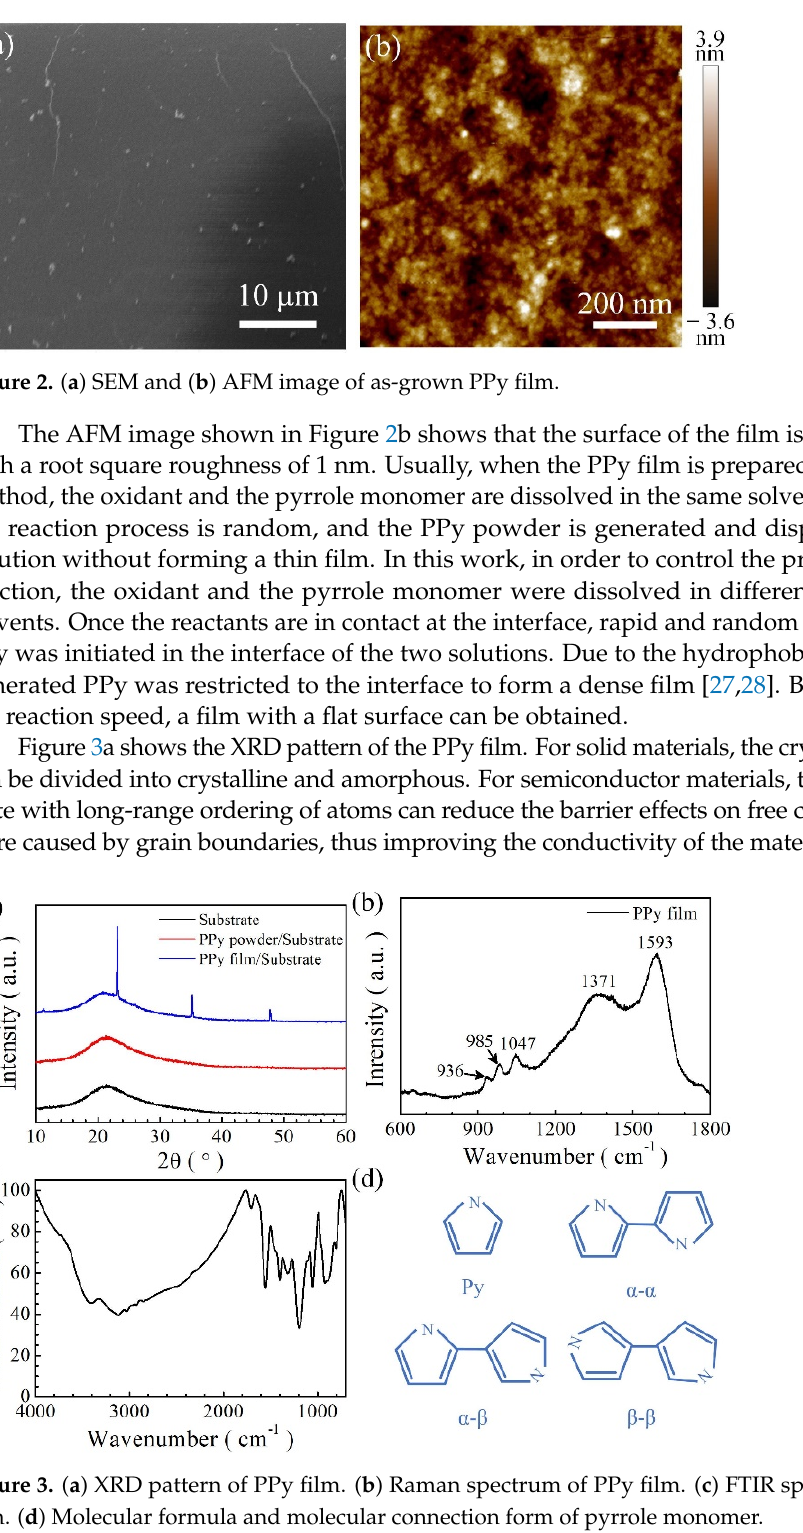
Figure 2. ( a ) SEM and ( b ) AFM image of as-grown PPy film.